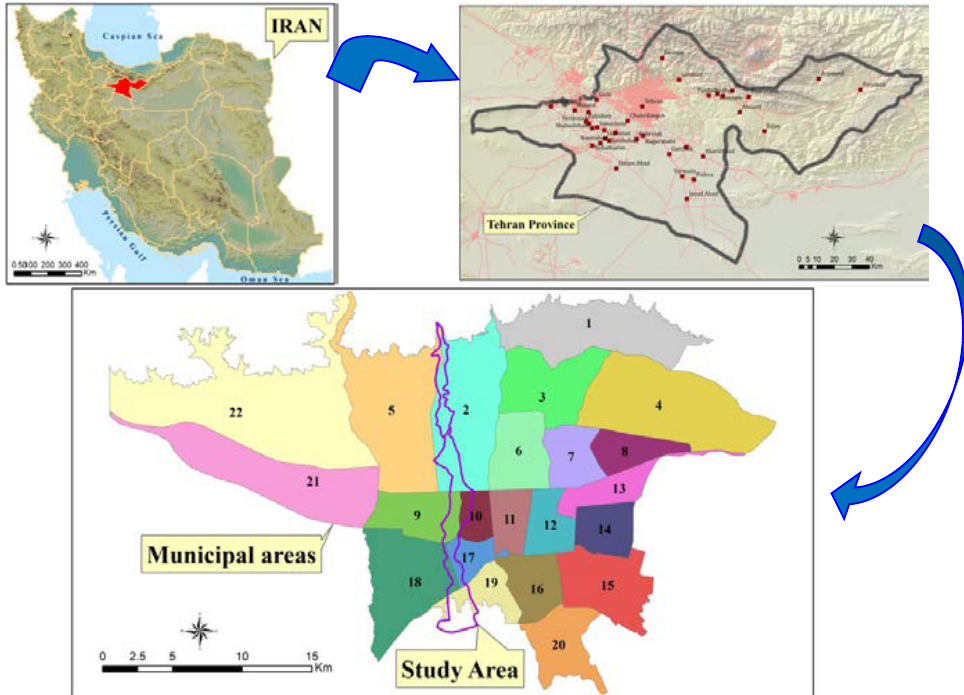
Fig. 1: Geographic location of the study area in Farahzad basin area, Tehran, Iran (Karimi et al. , 2018 )